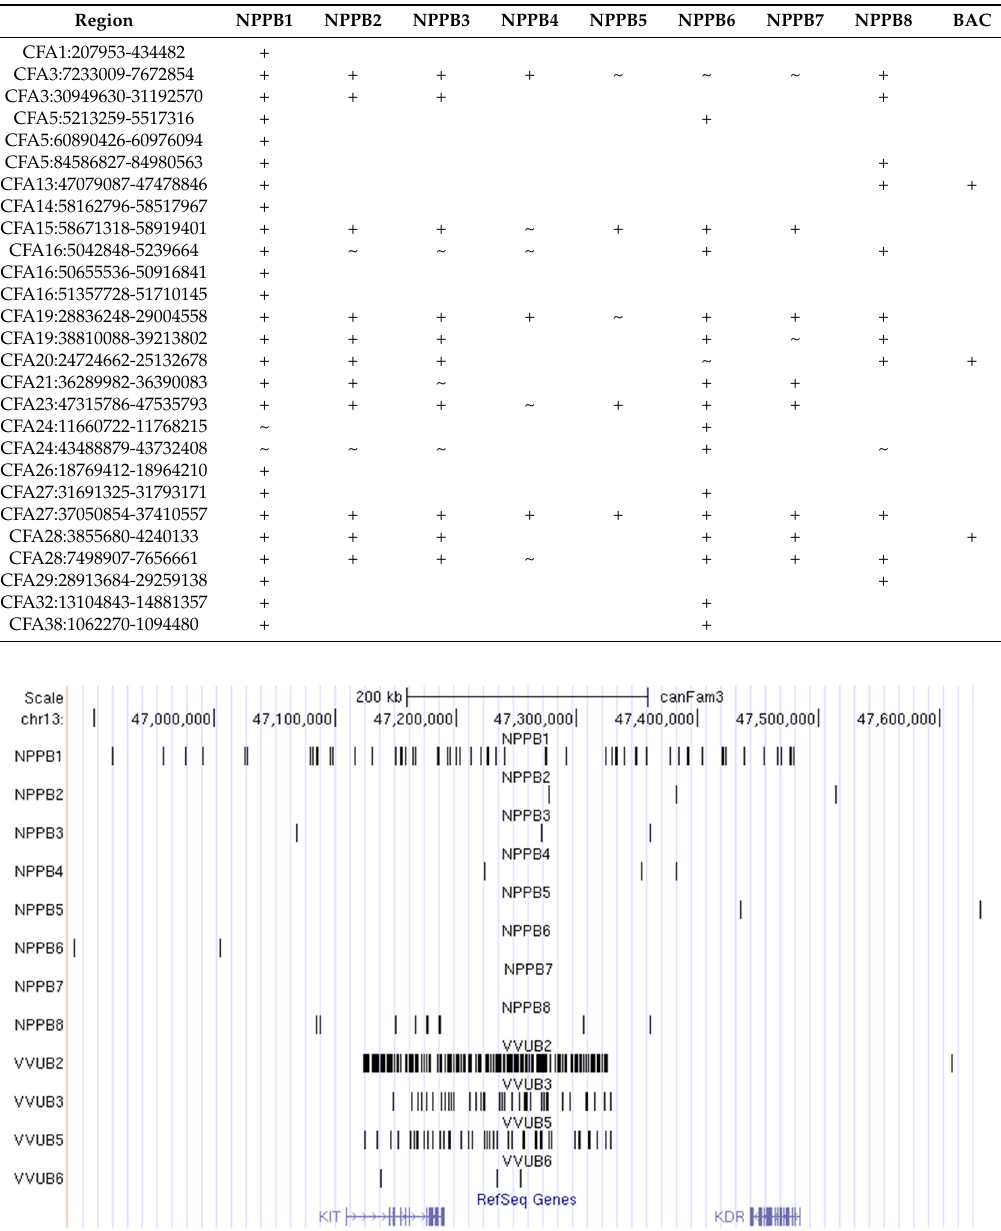
Table 2. Genomic regions of Chinese raccoon dog ( Nyctereutes procyonoides procyonoides Gray, NPP) Bs. Region coordinates are given according to dog (canFam3) genome assembly. NPPB1—flow-sorted Bs, NPPB2 and 3—whole microdissected Bs, NPPB4 and 8—microdissected distal part of Bs, NPPB5 and 6—microdissected proximal part of Bs, NPPB7—microdissected middle part of B, BAC—BAC clone mapping data from [20]. +—regions with >5 read positions (recovered automatically). ~— regions with <5 read positions (recovered manually).